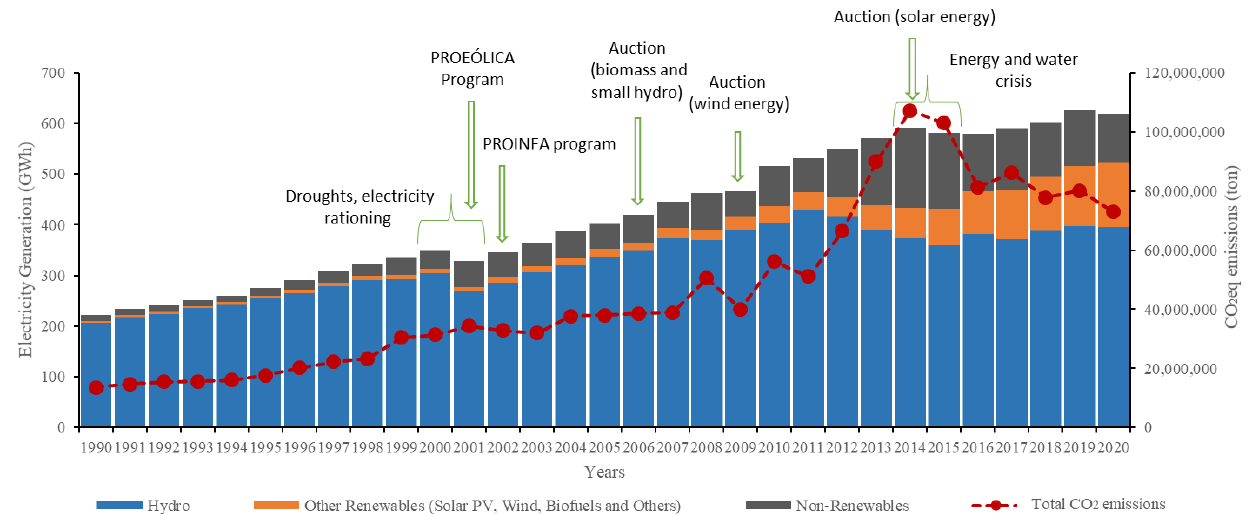
Figure 3. Brazil’s electricity generation from renewable (colored scale bars) and non-renewable (grayscale bars) sources and the total CO 2 eq emissions. Source: Elaborated by the authors based on [38–40]. Table 4. Main government incentives for the e ntry of renewable energy into Chile’s electricity sec- tor.